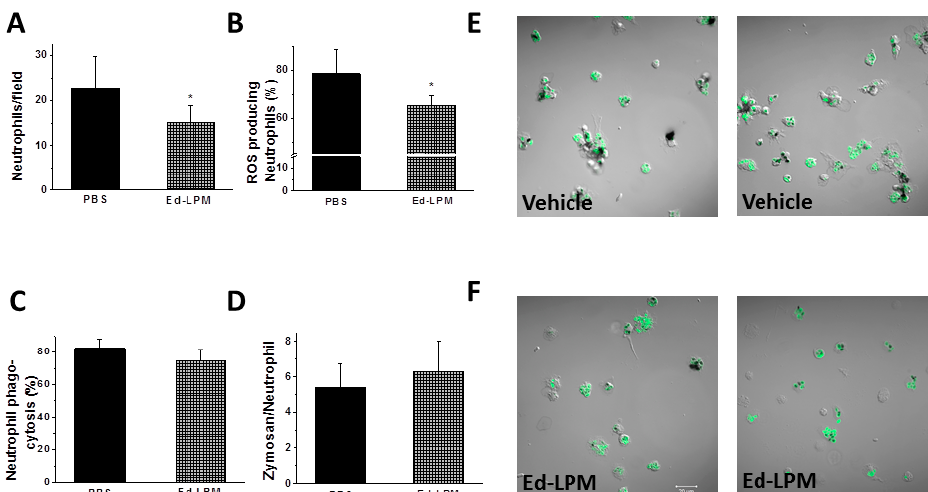
Figure 5. Ed-LPM therapy attenuated peritoneal neutrophils in septic rats. Ed-LPM therapy decreased neutrophil activation, as demonstrated by a lower number of neutrophils attached on the cover slip and counted per field (Panel A , p = 0.042), and decreased neutrophil ROS production (Panel B , p = 0.014), but did not alter neutrophil phagocytosis (Panels C , D ). Representative images of peritoneal phagocytosis and ROS production are provided (Panels E , F ). Quantification from 5 images from 3 experiments done in duplicate; * p < 0.05 vs. PBS group. n = 4–5 rats/group; p < 0.042 for Panel A and p = 0.014 for B .